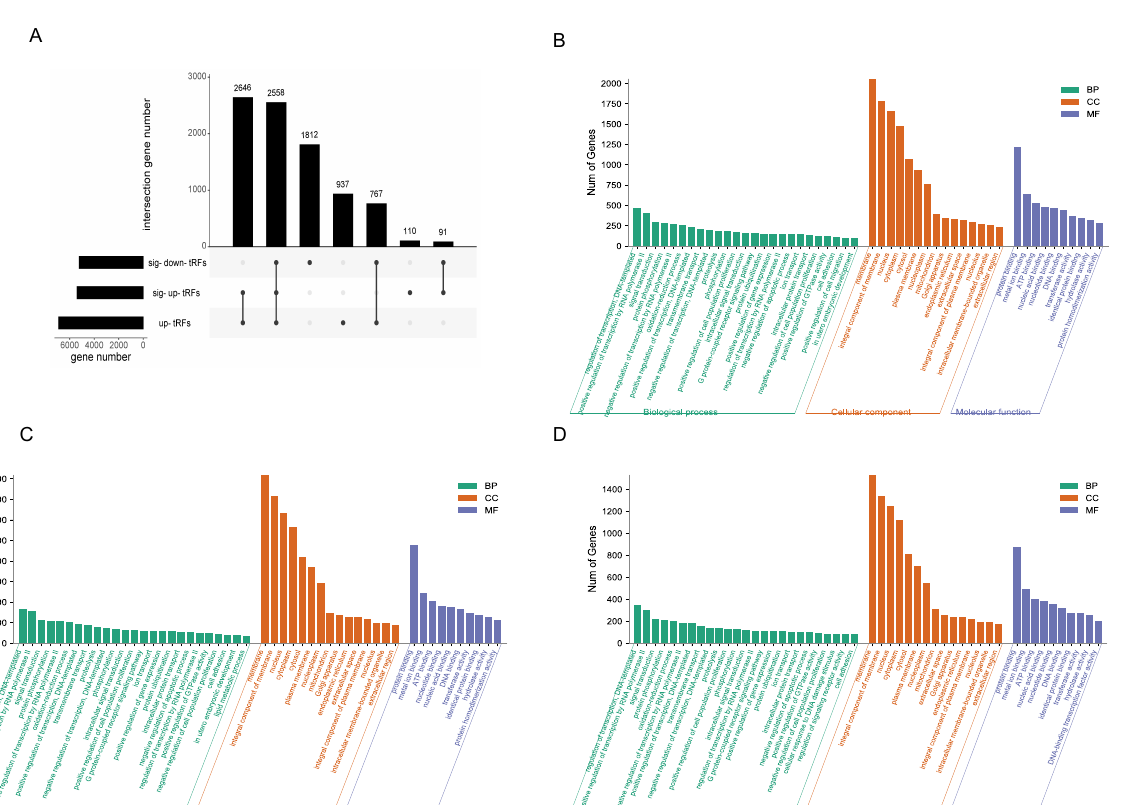
Figure 4. tsRNA target genes prediction and GO enrichment analysis. ( A ) The number of target genes and gene intersection distribution; GO enrichment analysis of target genes of increased ( B ), significantly increased ( C ), and significantly decreased ( D )